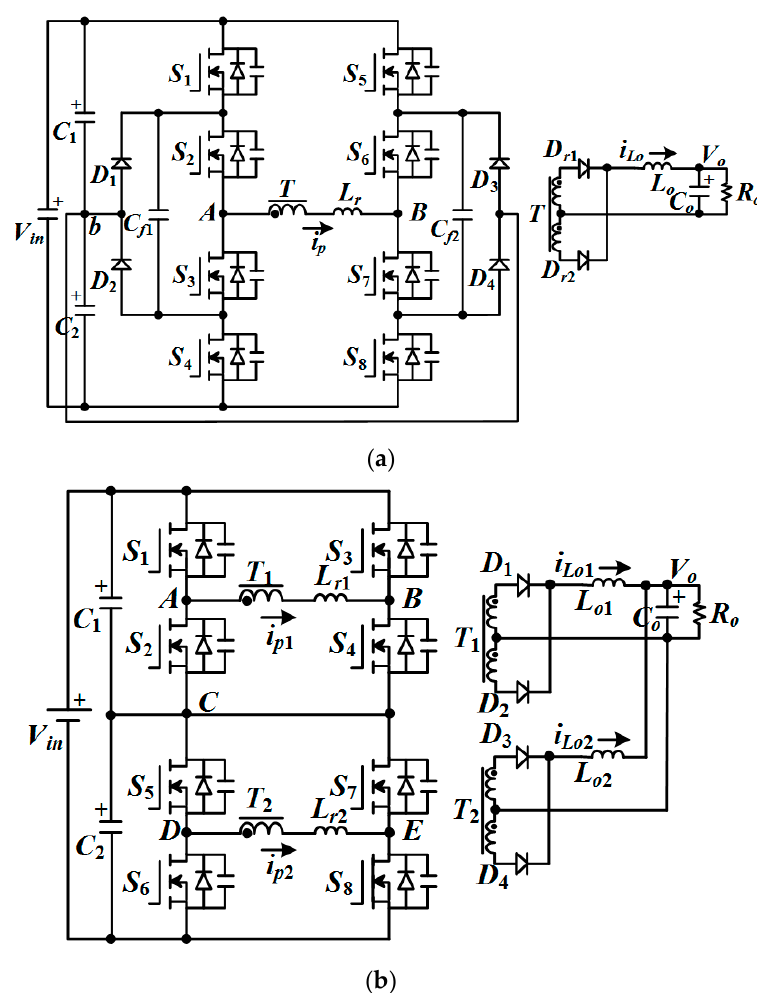
Figure 1. Circuit configuration of three-level converters ( a ) diode clamped three-level converter ( b ) cascade bridge three-level converter with primary-series and secondary-parallel.